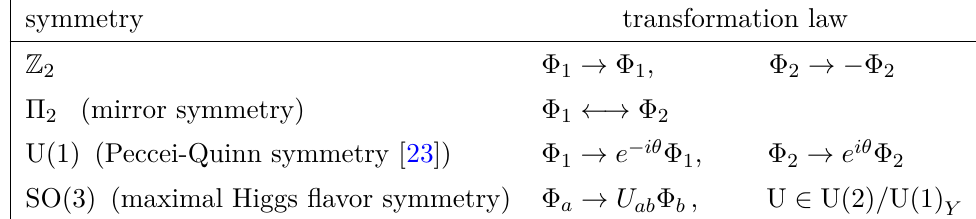
Table 1. Classification of 2HDM scalar potential Higgs family symmetries in a generic Φ 1 – Φ 2 basis [22, 43–46]. The corresponding constraints on the 2HDM scalar potential parameters are shown in table